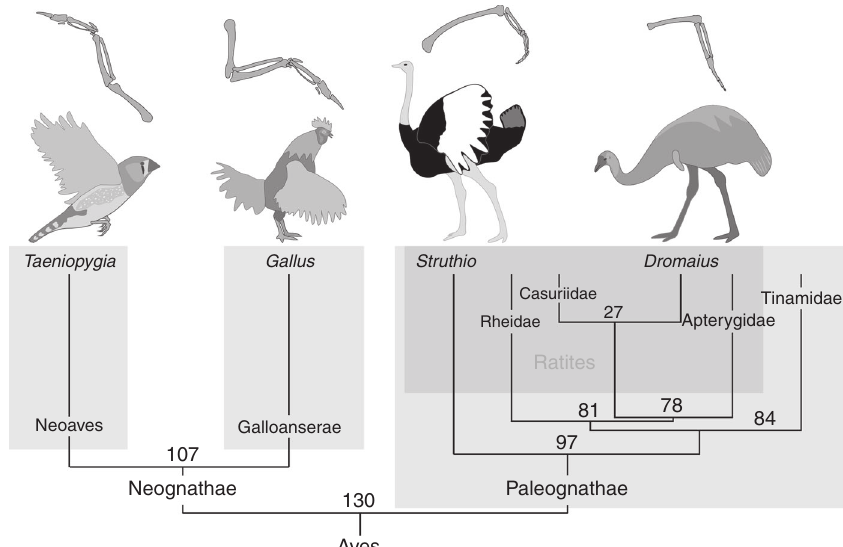
Fig. 1 Wing morphology and evolutionary relationships within Aves. Diagram illustrating the morphological variation in wing structure and skeletal con fi guration between the four avian species investigated, and chronogram illustrating the evolutionary relationships and times of divergence within Aves. Numbers above nodes represent time in millions of years before present. Shaded areas indicate each of the three major subdivisions within Aves. Family tree constructed from data in refs. 1,